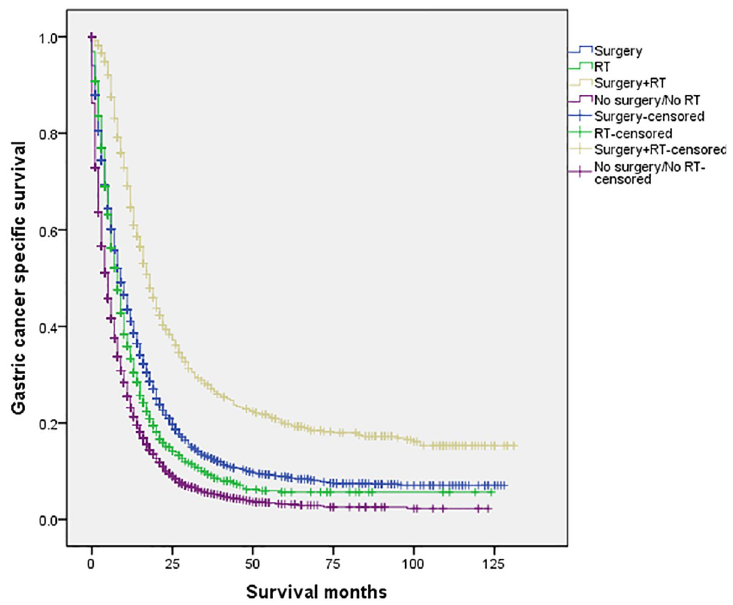
Fig 1. Survival curves in patients with advanced gastric cancer according to four subgroups. RT: radiation.